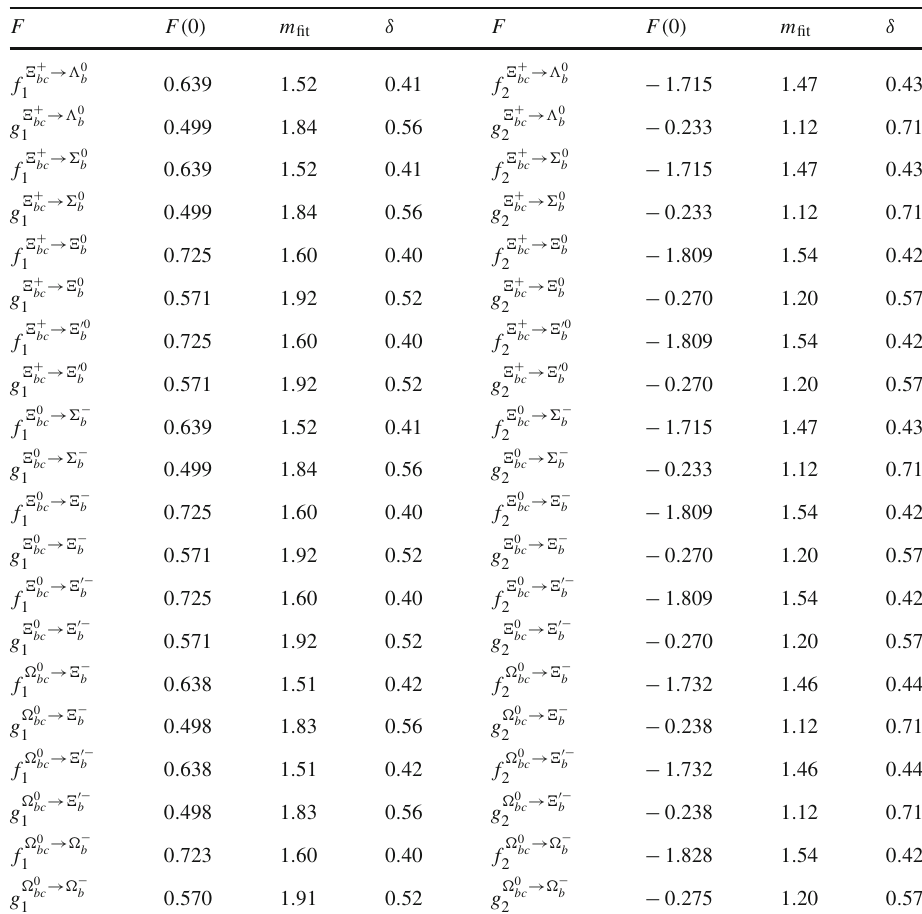
Table 12 Same as Table 8 but for the charm decays of bottom–charm baryons with scalar ( 0 + )